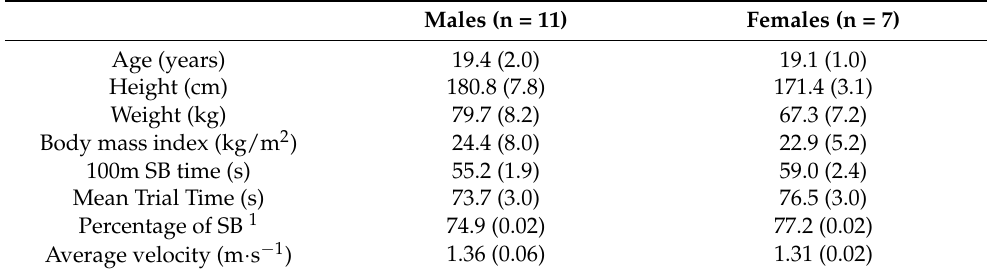
Table 1. Participant characteristics and 100 m trial data. Values are mean (±1) standard deviation.